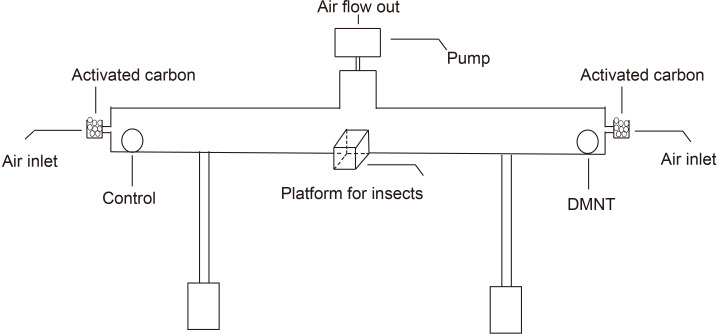
A schematic representation of the principle behind the insect choice test system.The horizontal box indicates the glass test tube. Equal amounts of activated carbon are placed at both ends of the test tube to avoid air contamination. The air flow is generated by an air pump. In all experiments, (3E)-4,8-dimethyl-1,3,7-nonatriene (DMNT) and control samples are placed on either end of the glass test tube, while 15 P. xylostella larvae are put on the platform located in the center of the test tube for the choice test.